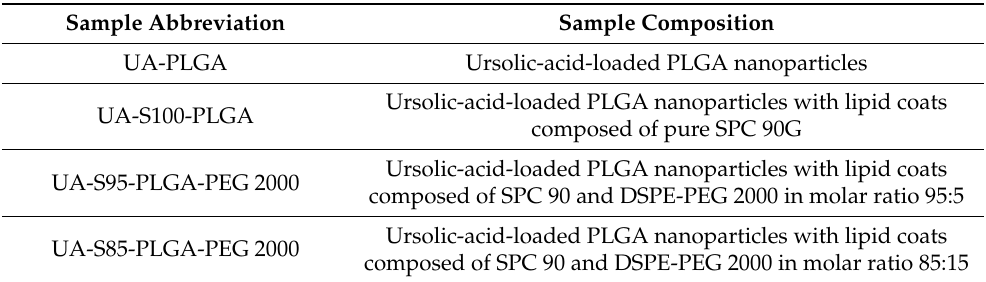
Table 1. UA-loaded hybrid nanoparticle compositions with respective